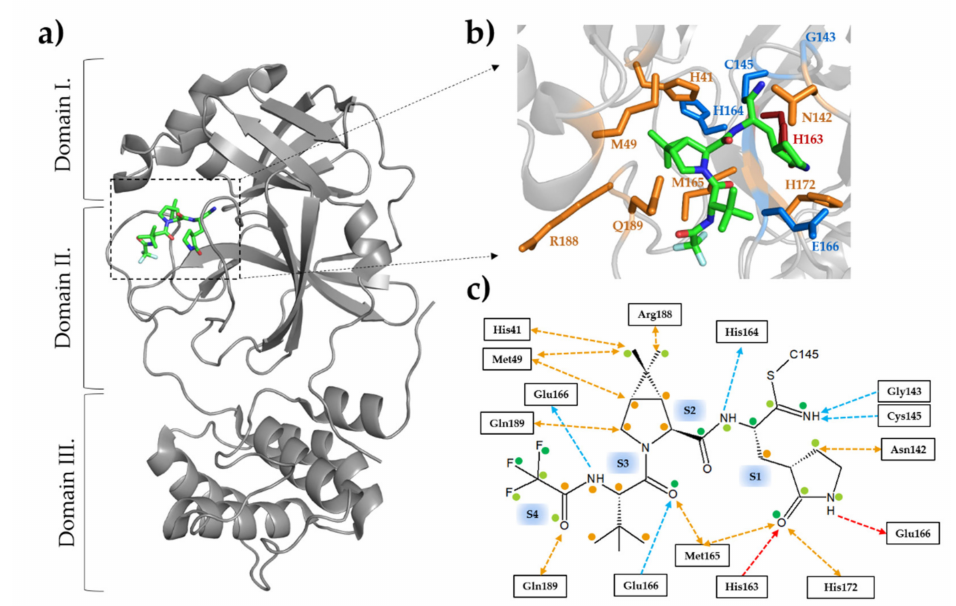
Figure 1. Structure of SARS-CoV-2 Mpro with nirmatrelvir. ( a ) The domain organization is repre- sented based on the crystal structure of the enzyme complexed with nirmatrelvir (7RFS.pdb). The inhibitor is represented as sticks, the carbon atoms are green, the oxygen atoms are red, and the nitro- gen atoms are blue. ( b ) Enlarged view of the active site showing the most relevant enzyme-inhibitor interactions. The active-site residues forming at least one main-chain- and side-chain-mediated hydrogen bond are colored by blue and red, respectively. The residues forming apolar interactions are shown in orange. ( c ) Most relevant inhibitor-binding interactions at the active site. The backbone- and side-chain-mediated hydrogen bonds are colored by blue and red, respectively. The direction of the arrow indicates the donated hydrogen atom. Apolar interactions are shown in orange. Colored dots indicate the average of non-bonded contacts for individual atoms. Orange represents 1